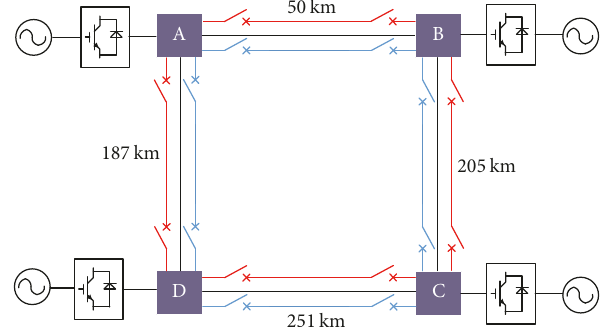
current limiting reactors are arranged on the pole lines and the metallic return lines; the values of reactance are 150 mH on the pole line and 300 mH on the neutral line. The reference voltage of pole line arrester is 629 kV and residual voltage is 904 kV under switch operation with 2 kA current.